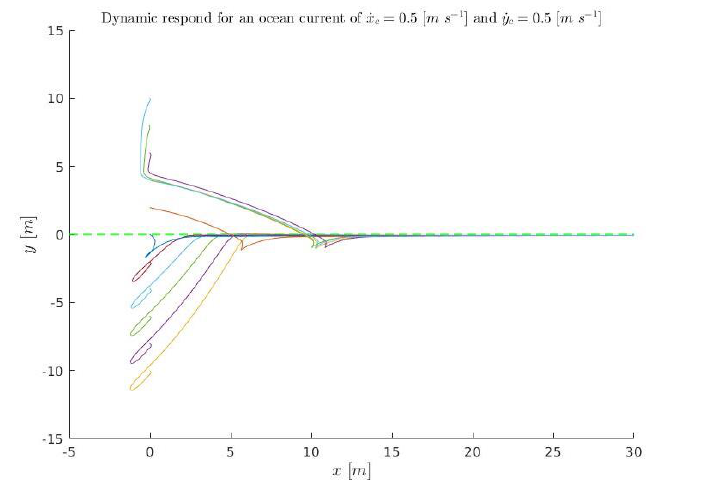
Figure 20. Dynamic simulation for the conditions (37). The color line represent the different simula- tions and the green discontinuous line the acceptance tolerance.